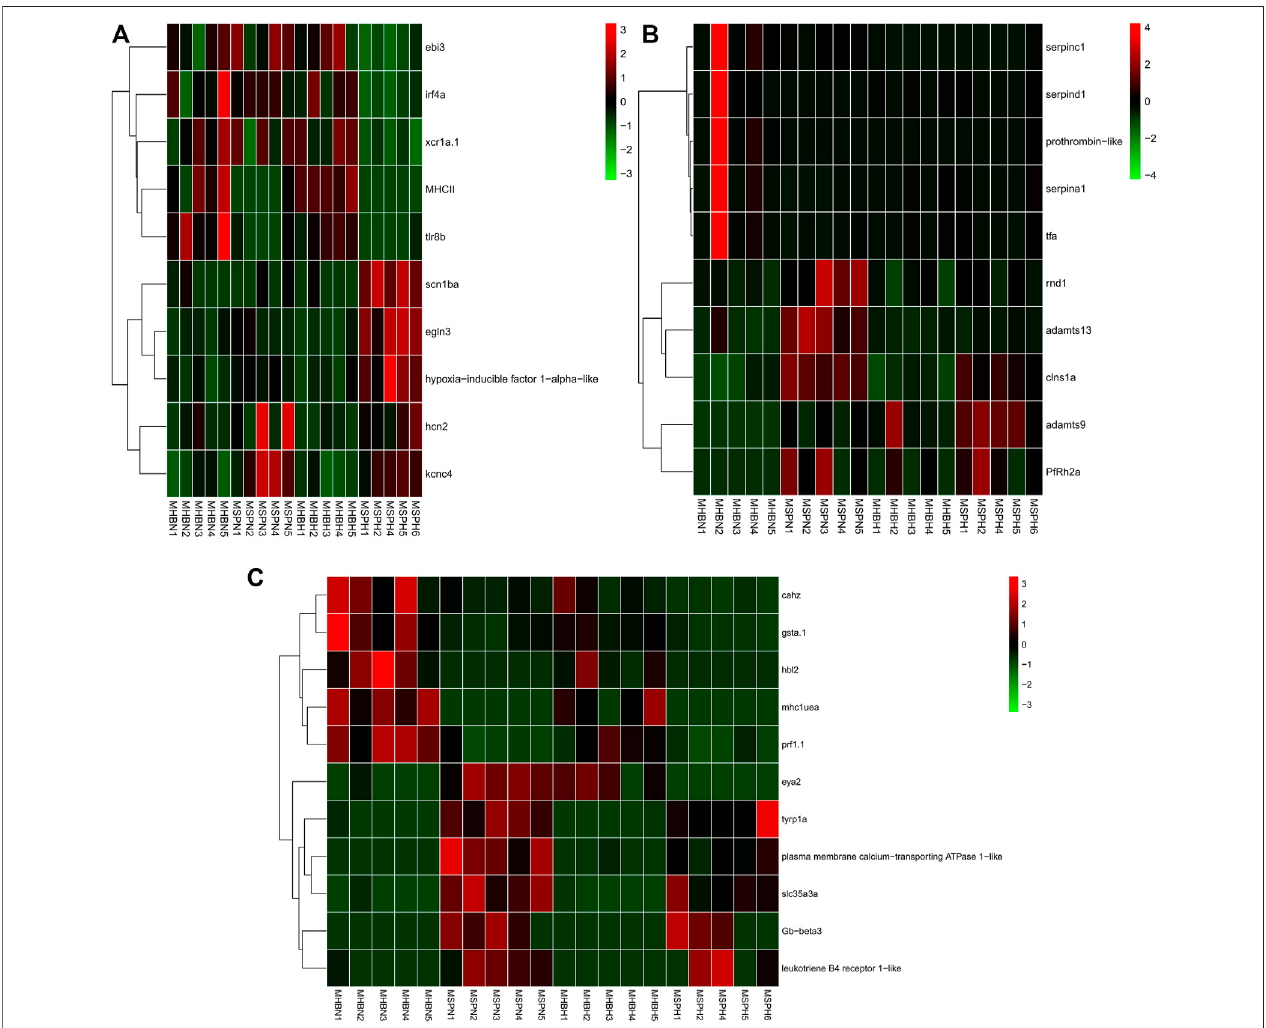
FIGURE 4 | Hierarchical clustering of the three types of genes among three strains of carp muscle under hypoxia based on the average correlation of the log2 expression values. (A) HSDEGs. (B) NSDEGs. (C) HNDEGs (MHBN1, MHBN2, MHBN3, MHBN4, MHBN5, MHBH1, MHBH2, MHBH3, MHBH4, MHBH5;